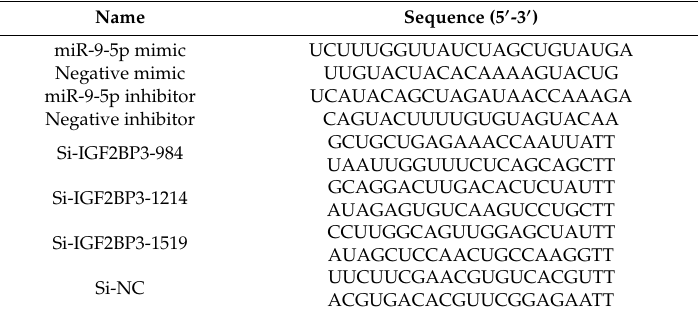
Table 1. RNA oligonucleotides in this article.